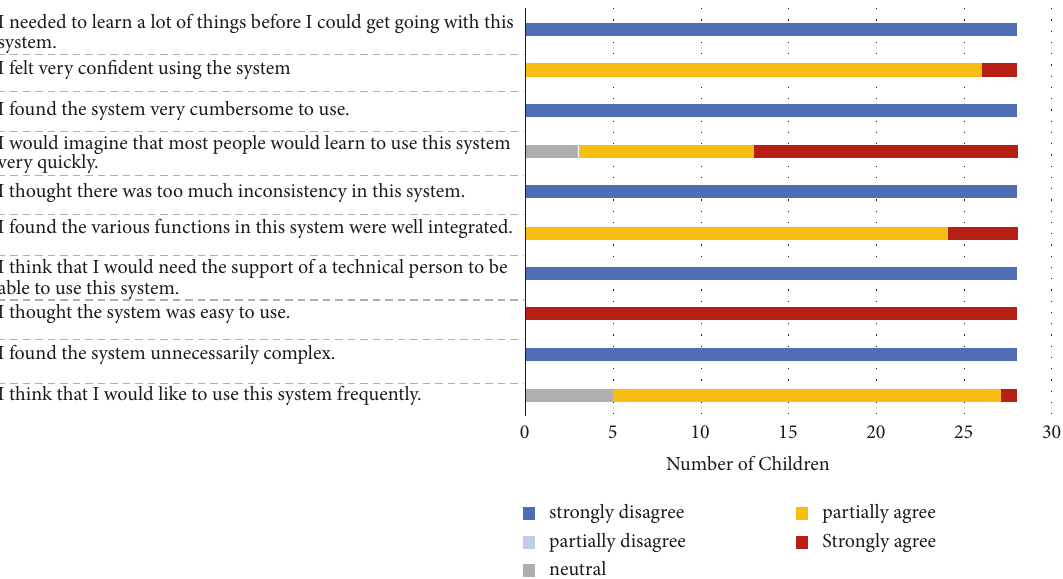
Figure25:Overalllevelofagreementofneurotypicalchildren,withusabilitythegameALTRIRASmeasuredthroughtheSUSscalequestions.